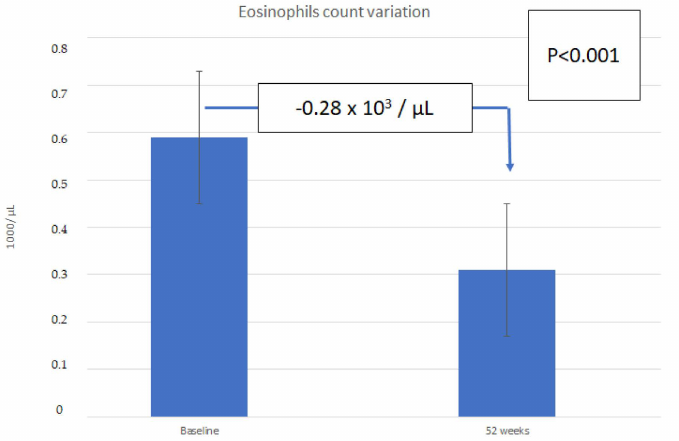
Figure 2. Change in circulating eosinophil count in children and adolescents with asthma (n = 12) after 52 weeks of treatment with Omalizumab.